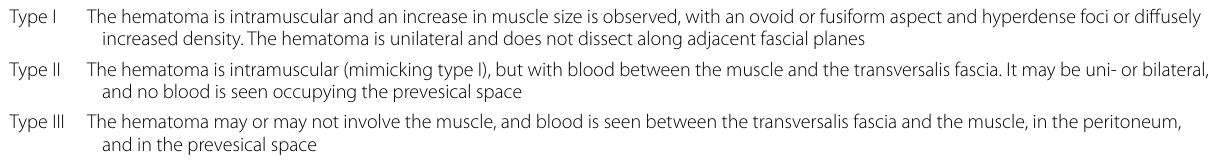
Table 1 Rectus sheath hematoma classification based on computed tomography. Modified from [8] Type